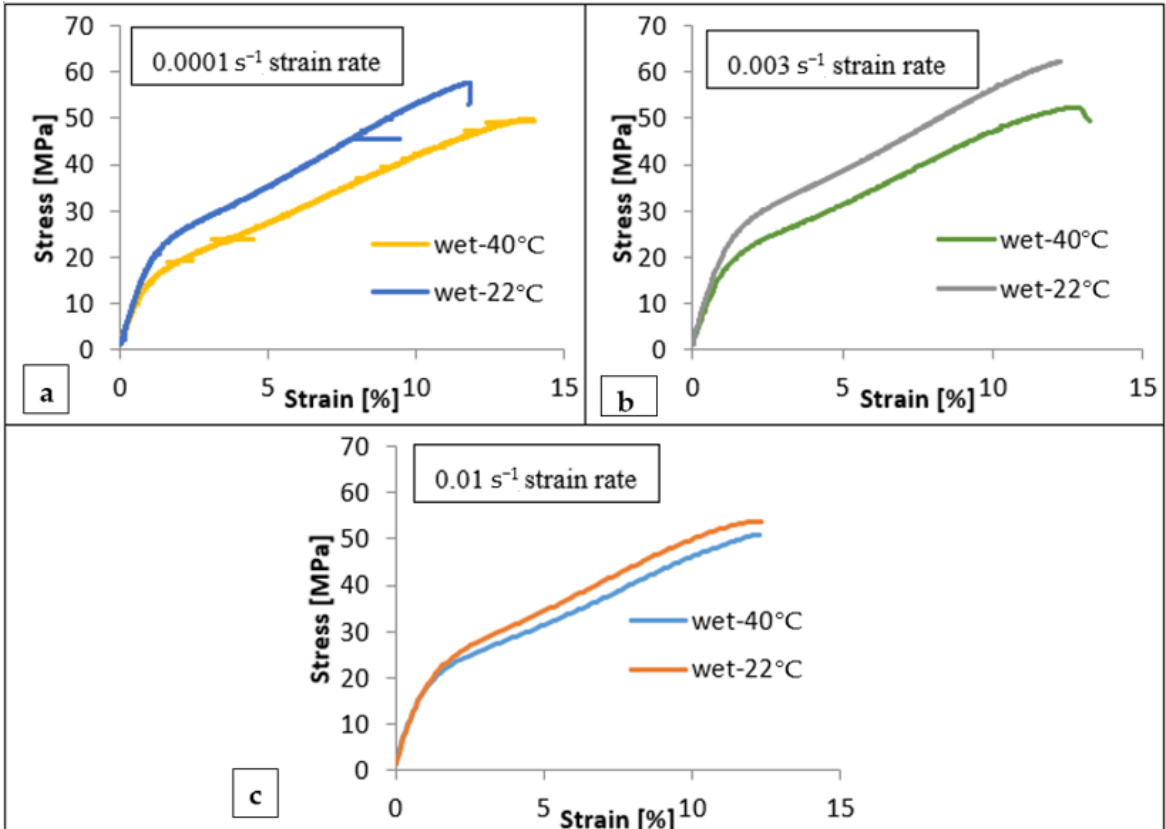
Figure 8. The effect of temperature on the engineering stress versus strain curves of the BW30-0 ◦ specimens at ( a ) 0.0001 s − 1 , ( b ) 0.003 s − 1 , and ( c ) 0.01 s − 1 strain